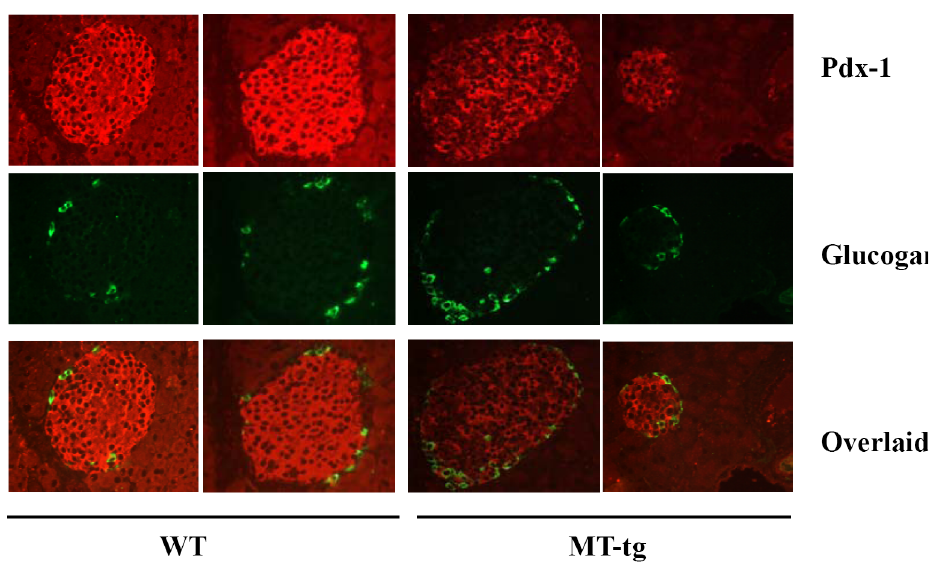
Fig 7. Decreased PDX1 level in pancreatic islets of MT-tg mice. PDX1 (red) and glucogan (green) immunostaining in islets of 8-week-old MT-tg and WT male